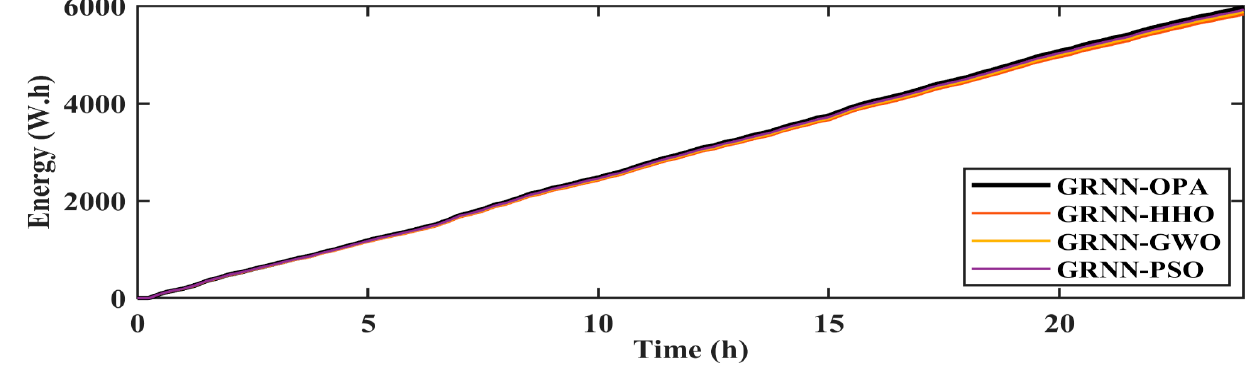
Figure 17. Comparison of energy extracted in case 3.